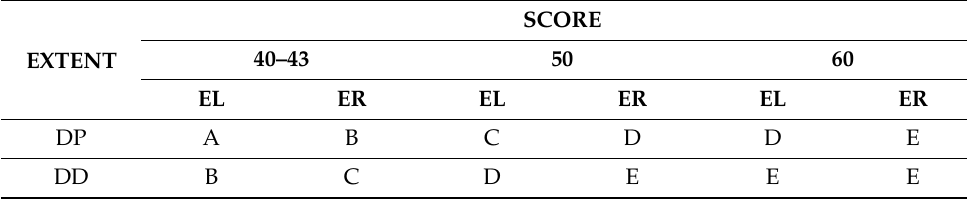
Table 2. Priority indices matrix, according to CUGRI methodology.